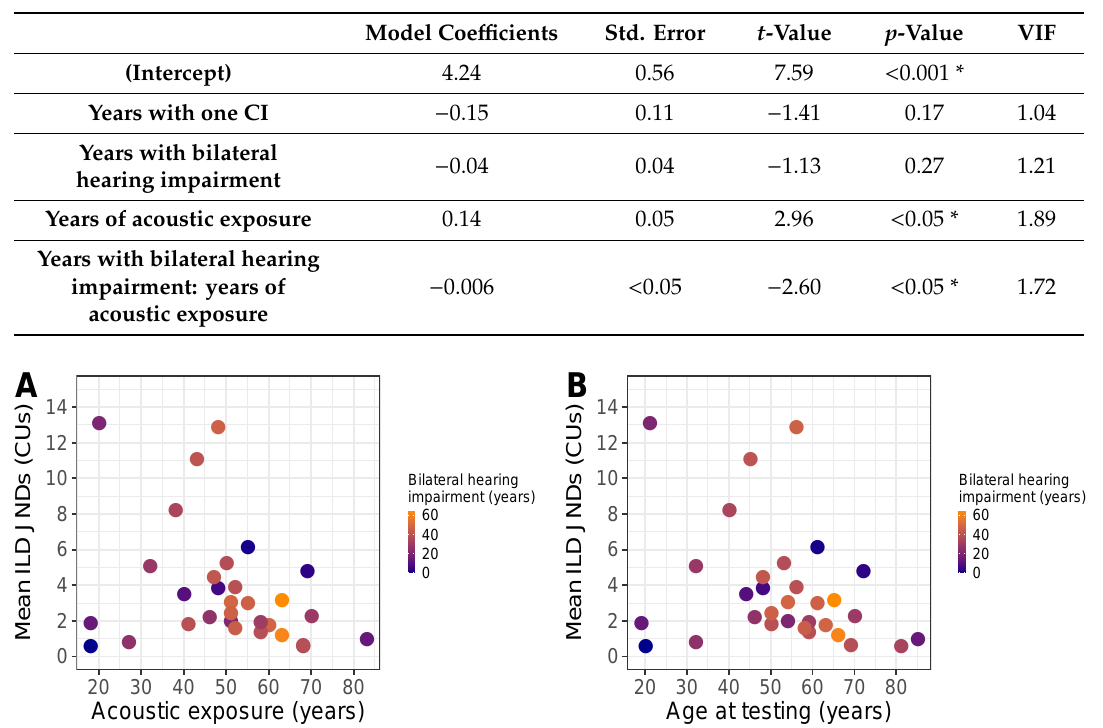
( B ) Shows ILD JNDs as a function of age at testing and years of bilateral hearing impairment. Blue-colored symbols indicate fewer years of bilateral hearing impairment and orange-colored symbols indicate greater years of bilateral hearing